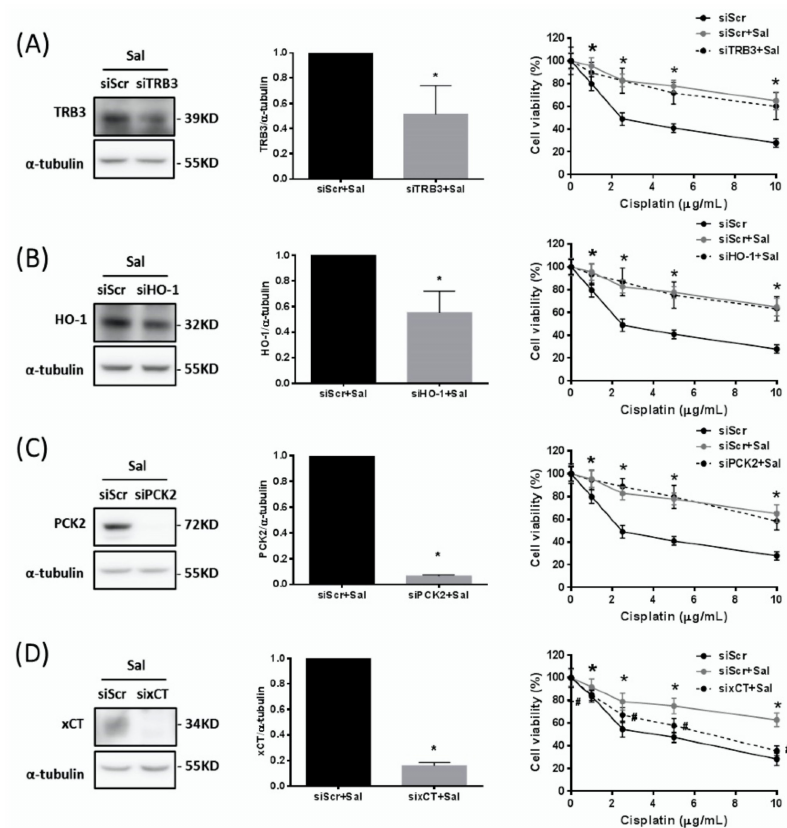
Figure 4. Up-regulated expression of xCT, but not of TRB3, HO-1, or PCK2, contributes to the salubrinal-induced cisplatin resistance. ( A – D ) Specific siRNAs against ( A ) TRB3, ( B ) HO-1, ( C ) PCK2, and ( D ) xCT (150 pmol for 2 × 10 5 cells in a six-well plate) were used to knock down TRB3, HO-1, PCK2, and xCT, respectively, in AGS gastric cancer cells, and the knockdown efficiency was determined using Western blotting. The control cells with scrambled siRNA (siScr) and the TRB3-, HO-1-, PCK2-, and xCT-knockdown cells (siTRB3, siHO-1, siPCK2, and sixCT) were treated with 30 µ M salubrinal (Sal) for 24 h. The cell viability was analysed by the SRB assay. The siScr cells and the siTRB3, siHO-1, siPCK2, and sixCT cells were pretreated with 30 µ M Sal for 24 h, and then co-treated with 30 µ M Sal and cisplatin for 48 h. Data are shown as the mean ± SEM of three independent experiments; * p < 0.05, compared with the siScr control group; # p < 0.05, compared with salubrinal-treated siScr